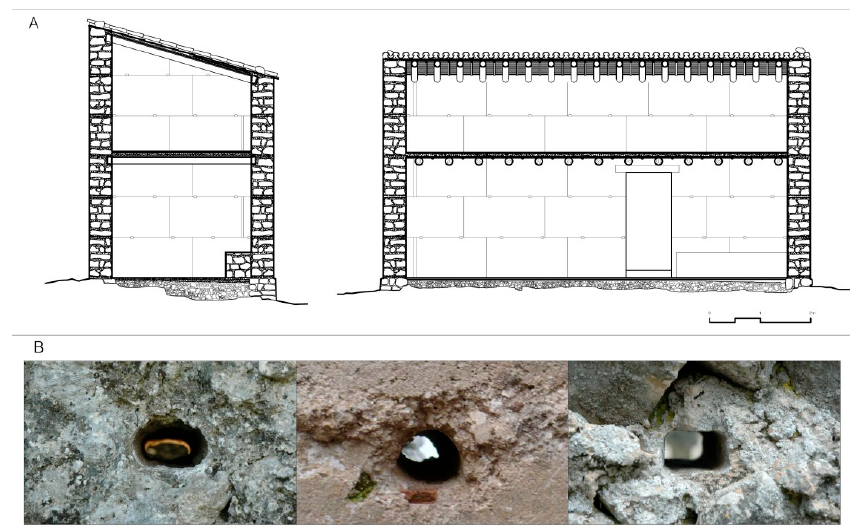
Figure 7. ( A ). Restitution of tapia modulation; ( B ): Putlog holes of horizontal timbers.